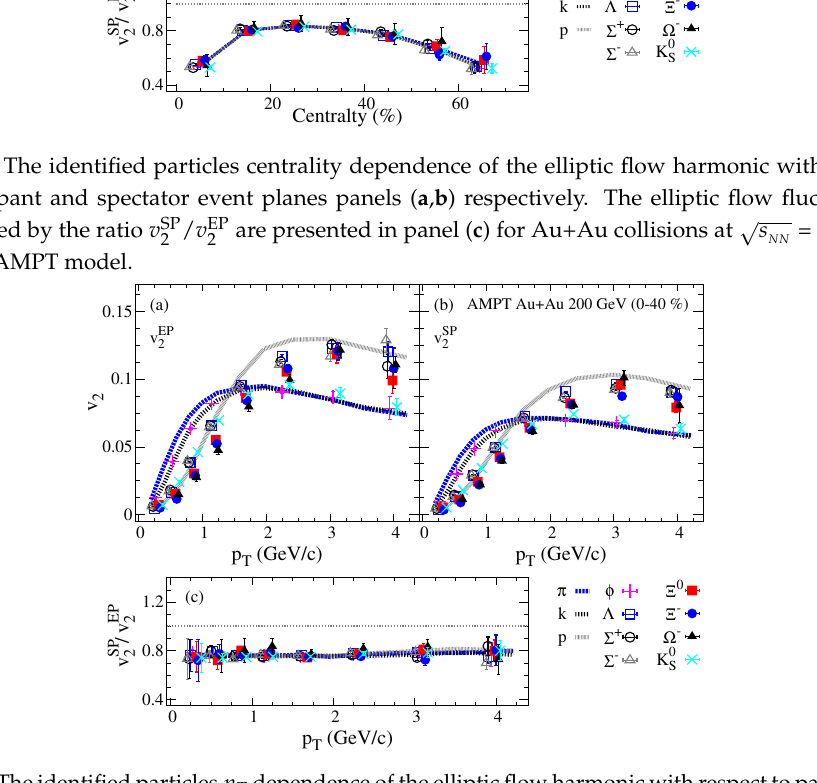
√ s = 200 GeV from the AMPT NN